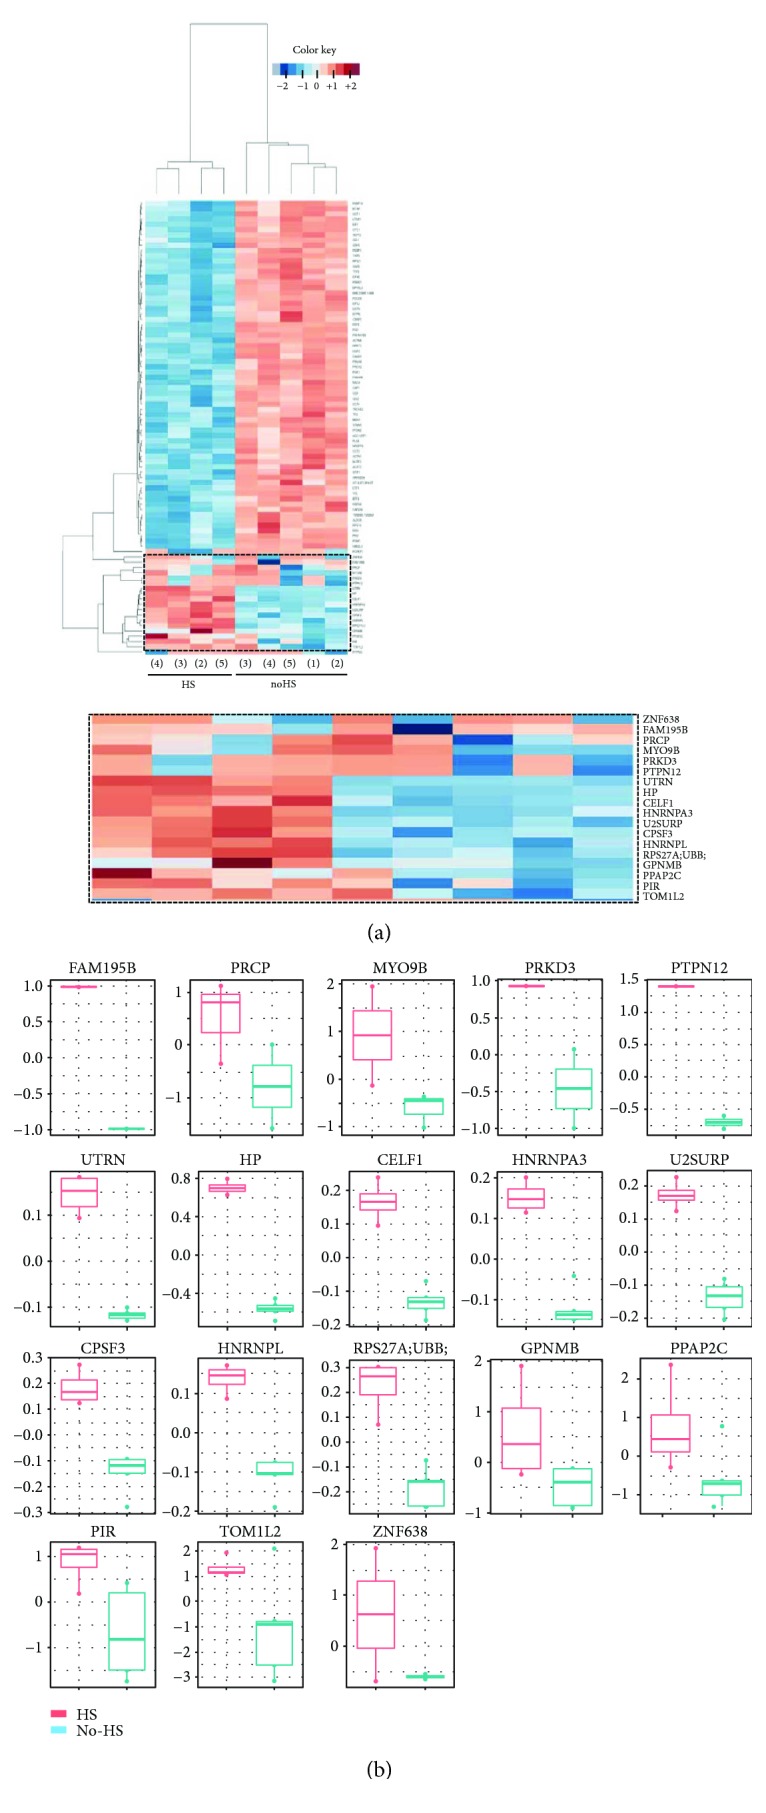
Expression profiles of selected proteins from TRIMEL and regulated by HS treatment. (a) Heat map with hierarchical clustering of proteins differentially expressed between TRIMEL (HS) and non-HS samples using a cutoff at p < 0.01. Protein names are displayed on the right and below is depicted an augmented section of the 18 HS-overexpressed proteins. Red, overexpressed; blue, underexpressed; and white, no change. The color-coded scale is indicated at the top of the chart. (b) Log-transformed relative protein expression of the 18 proteins regulated by HS treatment. The text and table only refer to 17 proteins because in one case a protein group was identified (RPS27A, UBB, UBC, UBA52, and UBBP4). It means the set of peptides matches all these five proteins and we cannot distinguish them here.